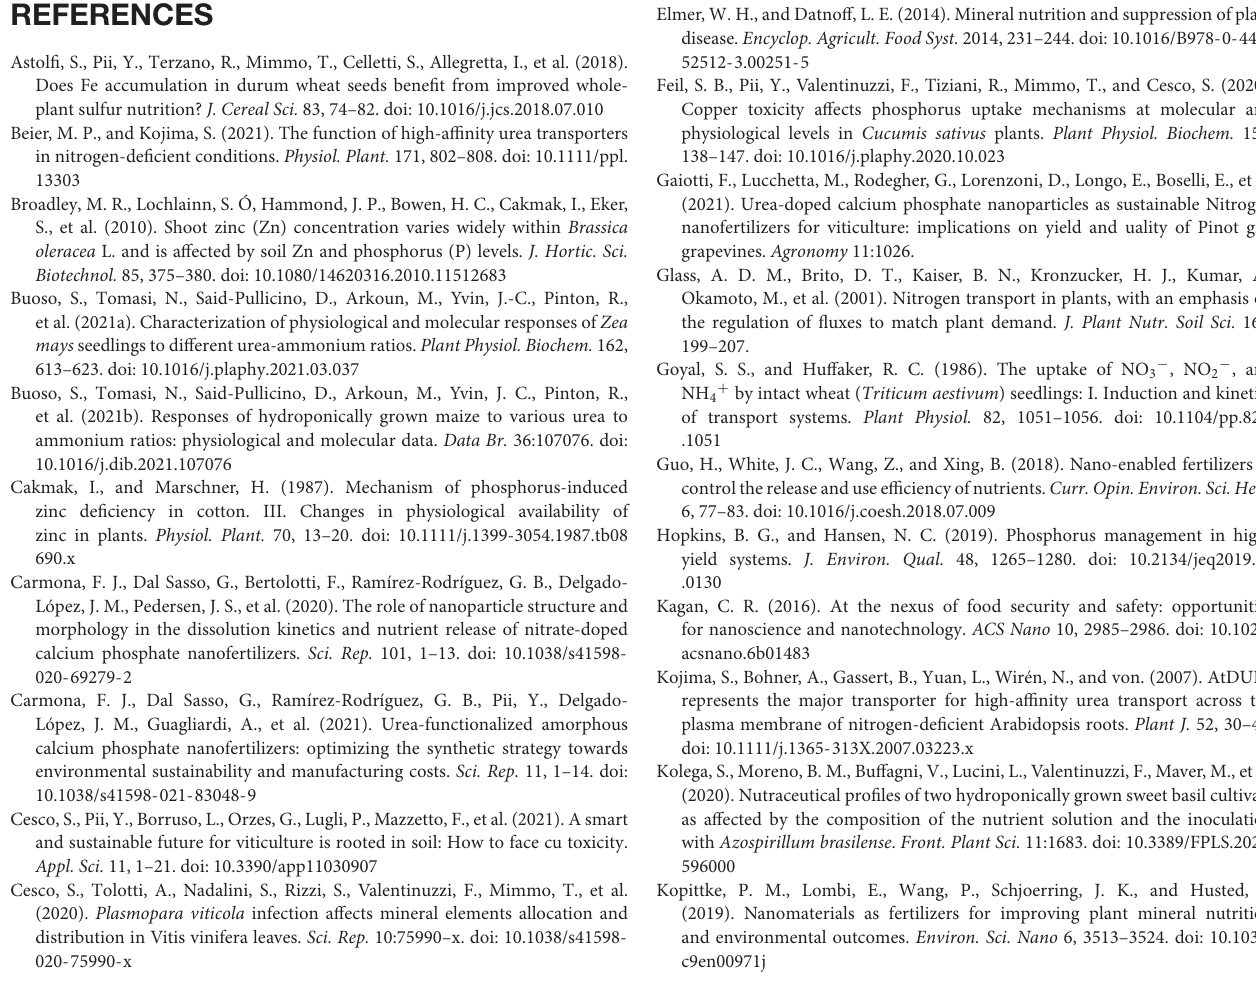
Supplementary Figure 2 | Schematic drawing representing the experimental plans. (A) Preliminary induction of cucumber plants with 1 mM Urea and determination of urea uptake rate and CsDUR3 expression. (B) Induction of cucumber plants with either 1 mM Urea, NP, or NP.5 × , and determination of urea uptake rate and CsDUR3 expression. (C) Mid-term experiment in which cucumber plants have been either not treated (control) or treated with 1 mM Urea, NP or NP.5 × for 7 days, for the following determination of growth parameters (i.e., SPAD index, root and shoot biomass, root architecture, and ionomic signature). Supplementary Figure 3 | Urea uptake in cucumber plants either not induced or induced with Urea. (A) High-affinity urea uptake rate in cucumber roots either not treated (not induced) or treated with 1 mM Urea. Uptake rates were determined by placing the seedlings in 200 µ M 15 N-labeled urea solution for 7 min. Data are the means ( ± SE) of three independent biological replicates; each biological replicate was obtained by pooling five independent plants. The statistical significance within each time point has been assessed by Student’s t -test. (B) Gene expression analysis of CsDUR3 in cucumber roots either not treated (not induced) or treated with 1 mM urea at 8HAT. CsDUR3 expression levels were assessed by qRT-PCR; data have been normalized to two internal controls, ubiquitin elongation protein and elongation factor 1- α tubulin. The relative expression ratios were calculated using not-induced roots sampled as calibrator. The data are means ( ± SE), n = 3. The statistical significance within each time point has been assessed by Student’s t